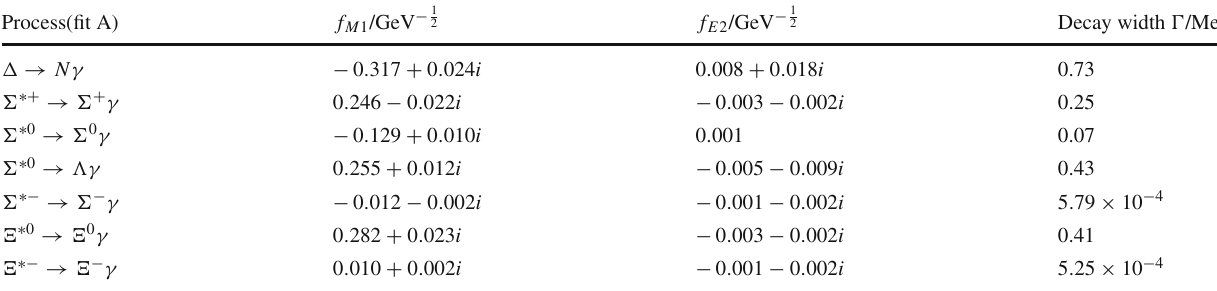
Table 13 M1 and E2 amplitudes and decay width of the decuplet to octet baryons in fit A Process(fit A)